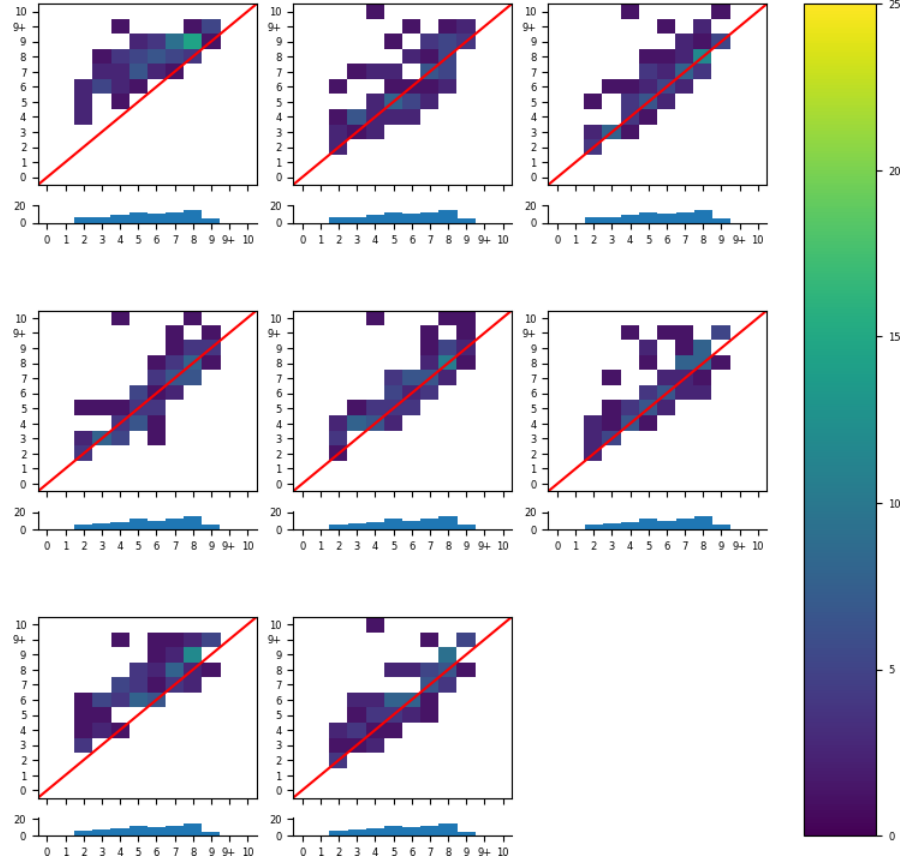
Figure 8. All eight analysts’ individual responses. The vertical axis shows the visually estimated ice concentration by the analysts, while the horizontal axis shows the calculated ice concentration from image segmentation. The histogram below each contingency table shows the number of polygons in each segmentation category. The colour bar is scaled to show the percentage of all polygons in the